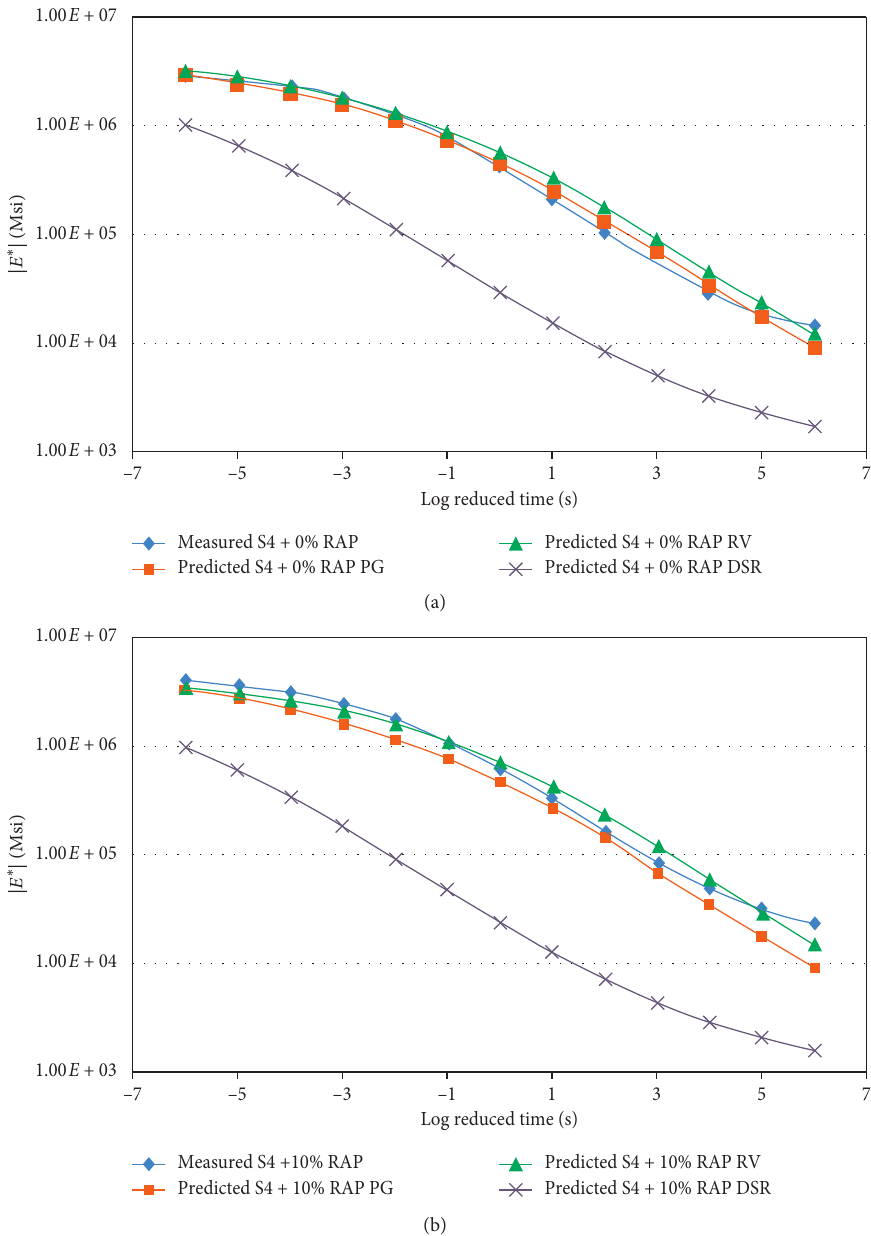
Figure 5: E ∗ master curves for S4 mixes: (a) S4+0% RAP and (b) S4+10%